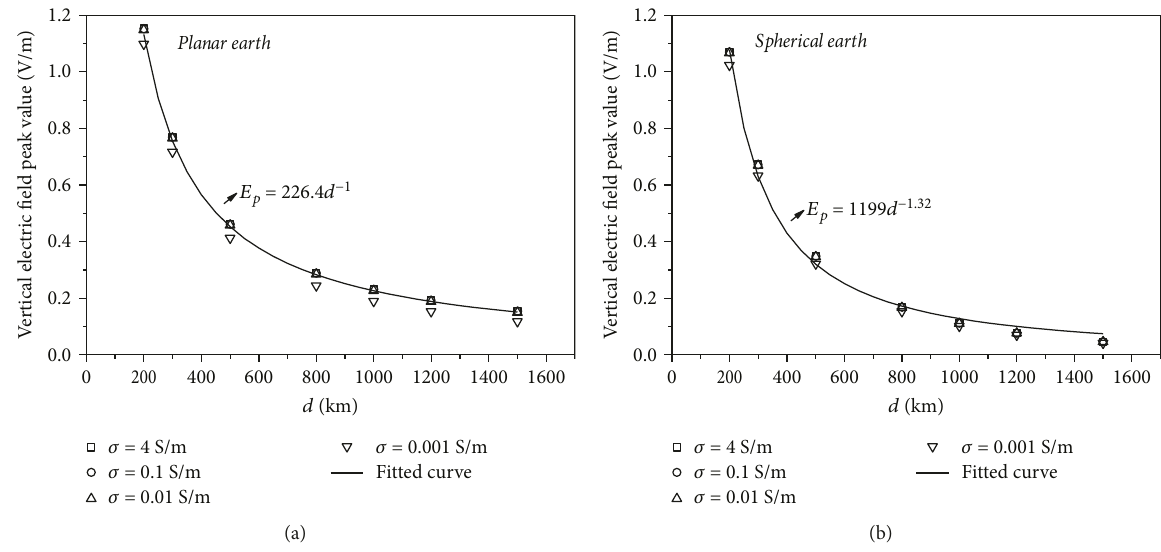
Figure 6: The (a) amplitude and (b) phase angle of attenuation functions ( σ =0.01S/m and d =1500km). W proposed by Wait [3, 4], accounting for the e ff ect of earth conductivity and curvature. Attenuation function W ρ only accounts the e ff ect of the earth curvature and W σ only accounts the e ff ect of the earth conductivity. W our = W σ W ρ is the attenuation function calculated using our approximate method.